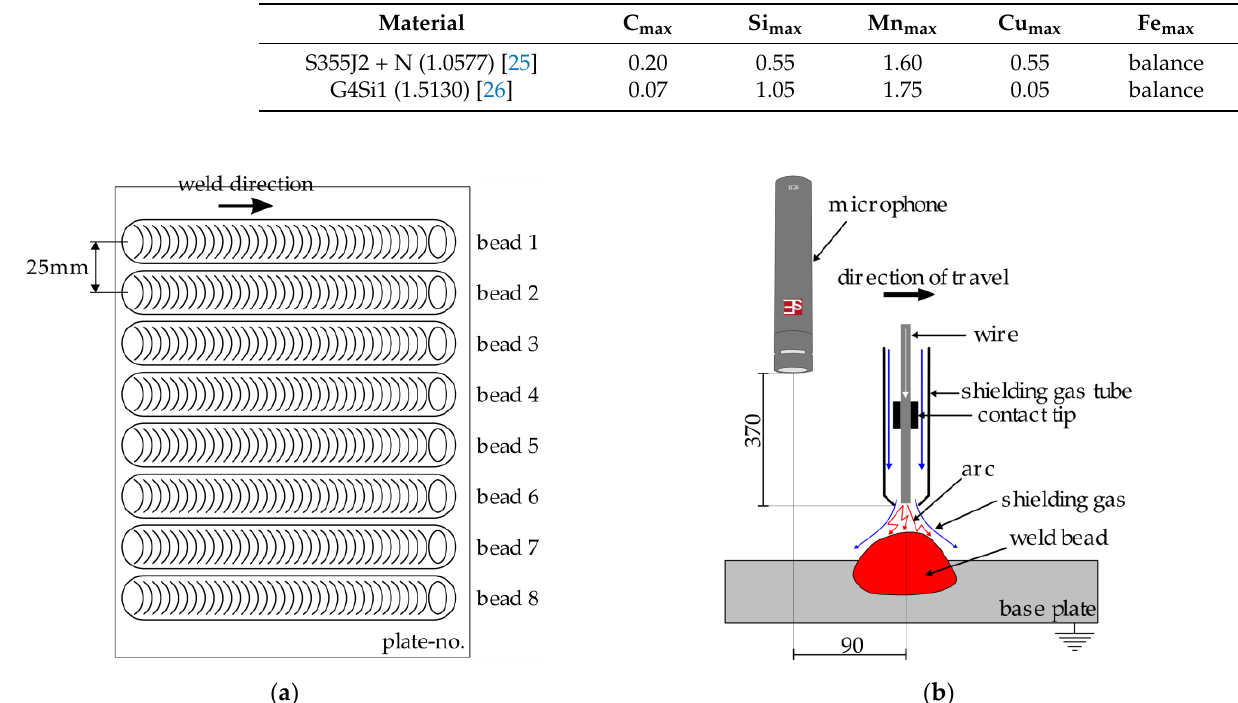
Figure 2. Positions of the beads and the microphone: ( a ) bead positions on the base plate and naming conventions; ( b ) microphone position relative to the arc with scheme of the GMAW welding torch.